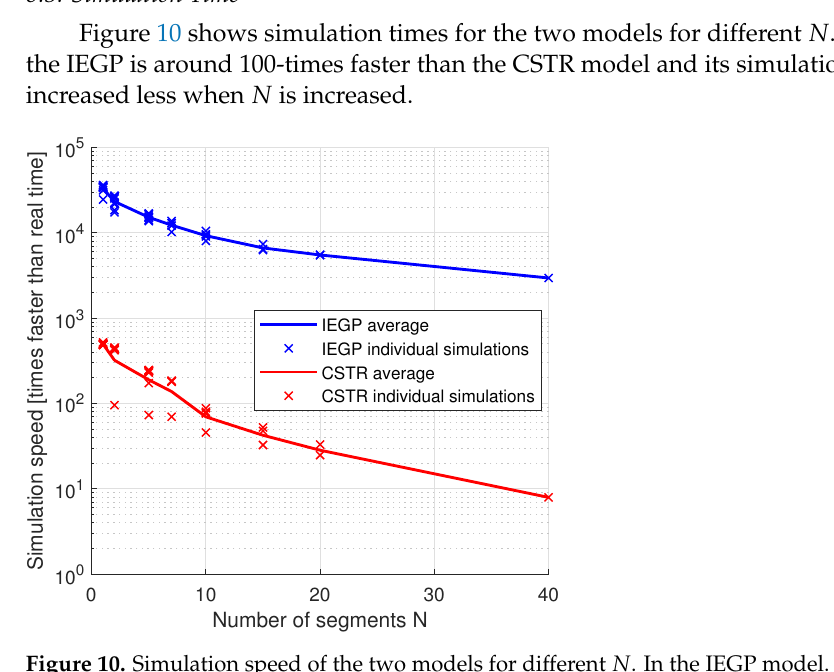
Figure 10. Simulation speed of the two models for different N . In the IEGP model. M = 2 and K = 5 were